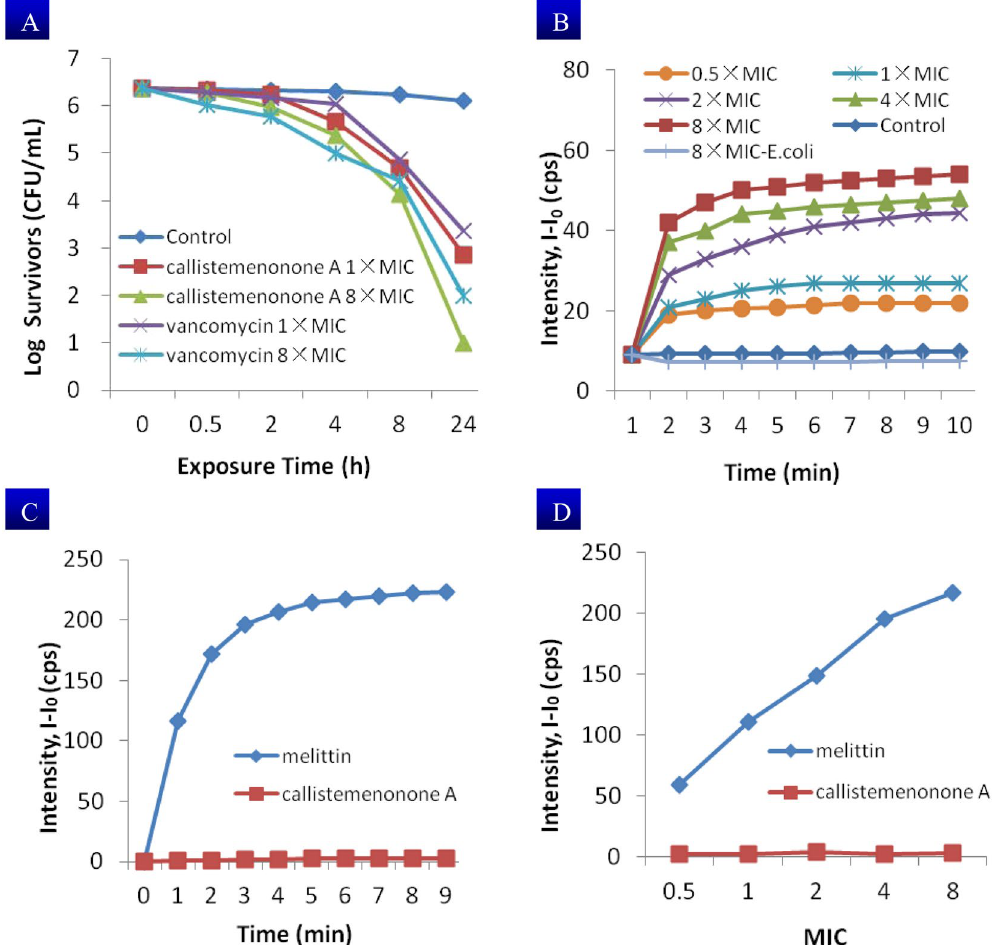
Figure 5. Antibacterial action of callistemenonone A ( 1 ). ( A ) Time-kill assay of MRSA (JCSC 2172) using 1 and vancomycin as control; ( B ) 1 -induced membrane depolarization of MRSA with different concentrations in the presence of DiSC3-5, DMSO was used as the untreated control with no effect on the depolarization, 8 × MIC concentration of 1 can not induce membrane depolarization of E. coli ; ( C ) SYTOX green assay of MRSA with 1 (8 × MIC = 160 μ g/mL) and melittin (10 μ g/mL) as positive control; ( D ) SYTOX green assay after treating MRSA with different concentrations of 1 for 4 h and melittin as positive control. MIC values: callistemenonone A = 20 μ g/mL, melittin = 1.25 μ